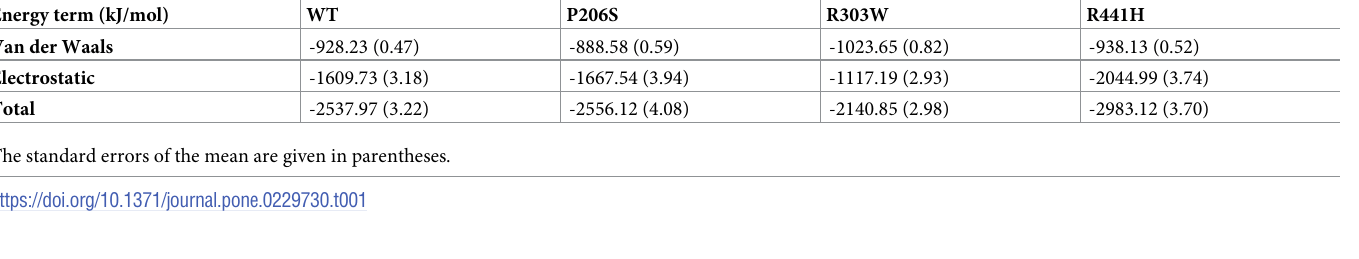
Table 1. MM-PBSA analysis of WT TPH2 and its variants. Energy term